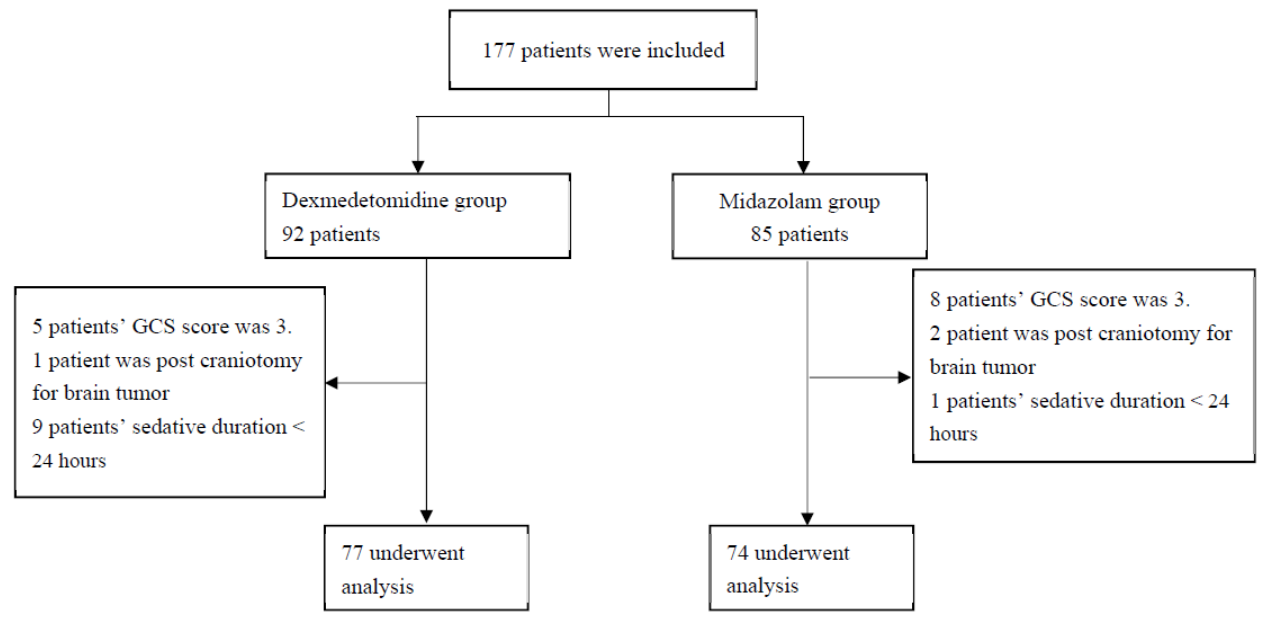
Figure 2. Flowchart of enrollment in the study. GCS: Glasgow Coma score.